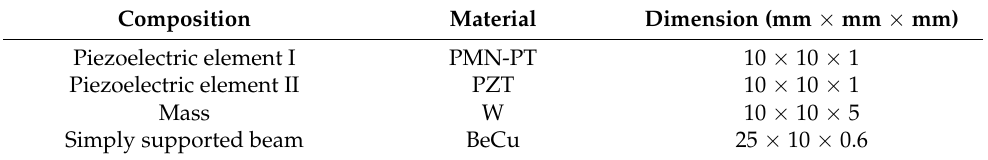
Figure 13. The structure diagram of the control system. Table 2. The dimensions of piezoelectric elements and the simply supported beam used in this work.